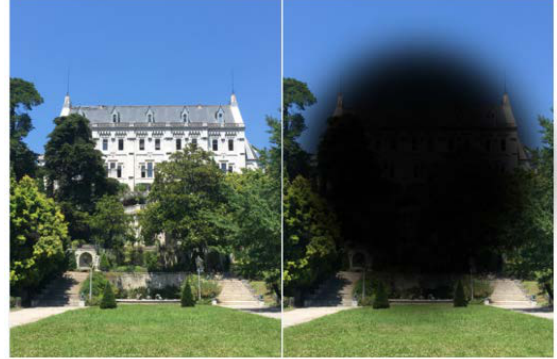
Figure 2. Incidence in Europe of the various eye diseases in people over 65 years of age [7]. However, AMD is the most common eye disease, and it covers different types of lesions affecting the macula. Its early-stage, so-called “early AMD”, is usually asymptomatic but could evolve into two advanced forms: the atrophic (dry) or the exudative (neovascular or wet) AMD. These aggravations can occur over few months or several years, and depend on various and poorly understood parameters, such as demographic, environmental, genetic, gender, and phenotypic risk factors [8]. Contrary to early AMD, the advanced forms are characterized by a central vision loss combined with metamorphopsia (distorted perception of straight lines and wavy images) and with scotoma (dark spot), rendering progressively the daily activities (e.g., reading and driving) tricky to impossible (Figure 3) [4]. The mechanisms underlying these two advanced forms are not entirely characterized, which make the development of a global cure against AMD very challenging. To this day, no efficient and curative treatment exists for AMD, and this pathology is considered in western countries as a leading cause of blindness for patients over 65 years.